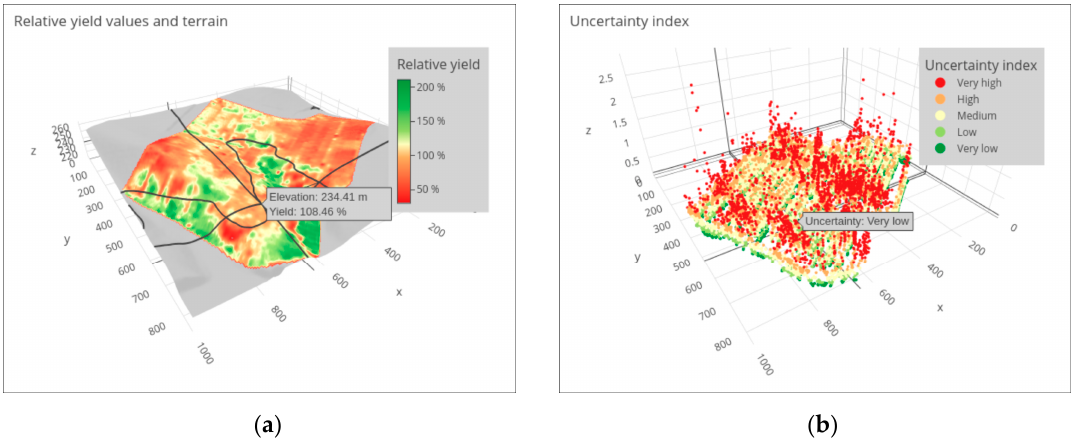
Figure 10. Application of the perspective heights method to uncertainty values and the measured data on relative yield ( a ) and uncertainty index ( b ). Three slicing lines were applied for the visualization of relative yield (X, Y, Z), while two slicing lines were applied for the visualization of the uncertainty index (X, Y). Note, the interactive version is available at https: // bl.ocks.org / SLeitgeb / raw / 5ebc03f461b79386002cdeca308c09ac / ?fbclid =